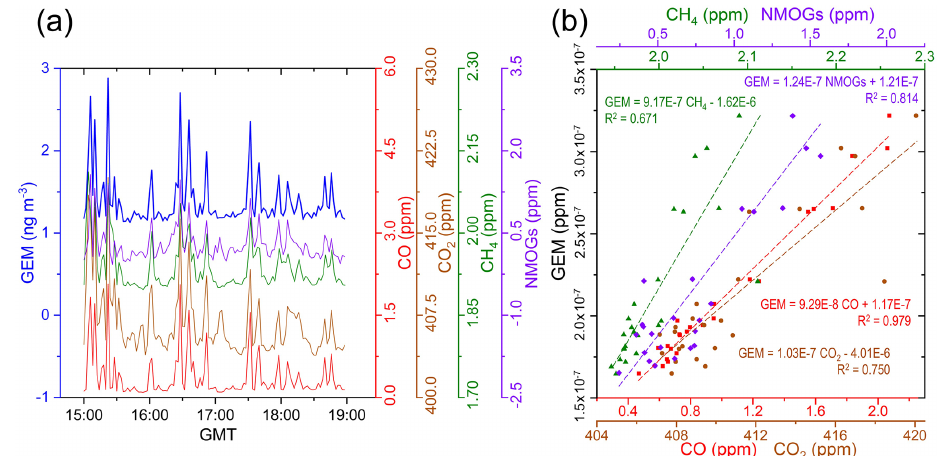
Figure 3. (a) Concentrations of GEM (2min measured) and mixing ratios of CO, CO 2 , CH 4 , and NMOGs during fire monitoring flight. (b) Mixing ratio orthogonal regressions of GEM against CO, CO 2 , and CH 4 during the wildfire monitoring flight (these data are based on only the GEM data elevated > 1 . 25 × the background concentration; n = 24); ERs are derived from the slopes of these regressions. Uncertainty terms for these slopes (ERs) are given in Table 1. Table 1. Enhancements, ERs, and EFs of GLP fire and the most comparable fires with near-source measurements of GEM. This study Brunke et al. (2001) Friedli et al. (2003a) Friedli et al. (2003b) Cape Point, South Africa N Ontario, Canada Washington State,